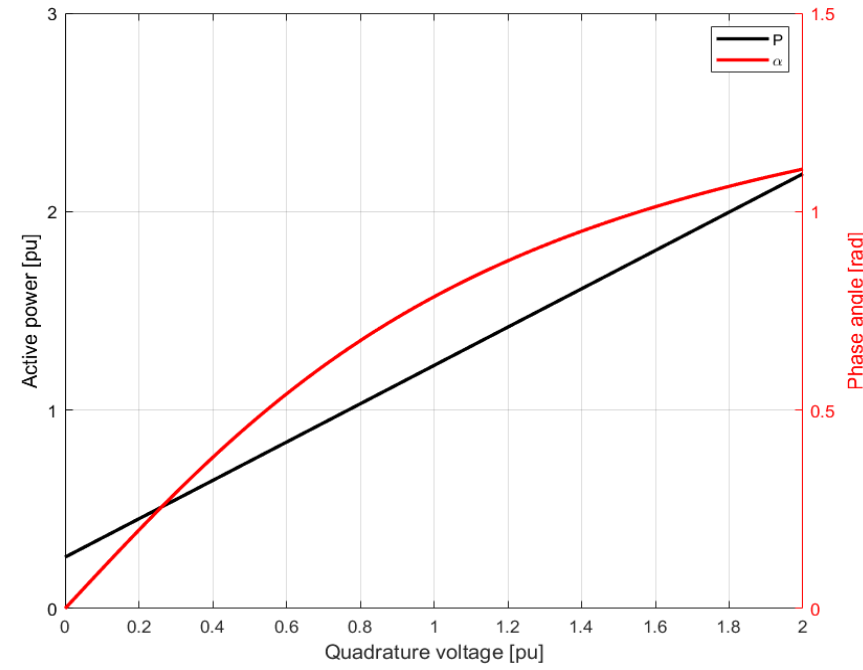
Figure 1. APST active power flow and angle versus injected quadrature voltage.